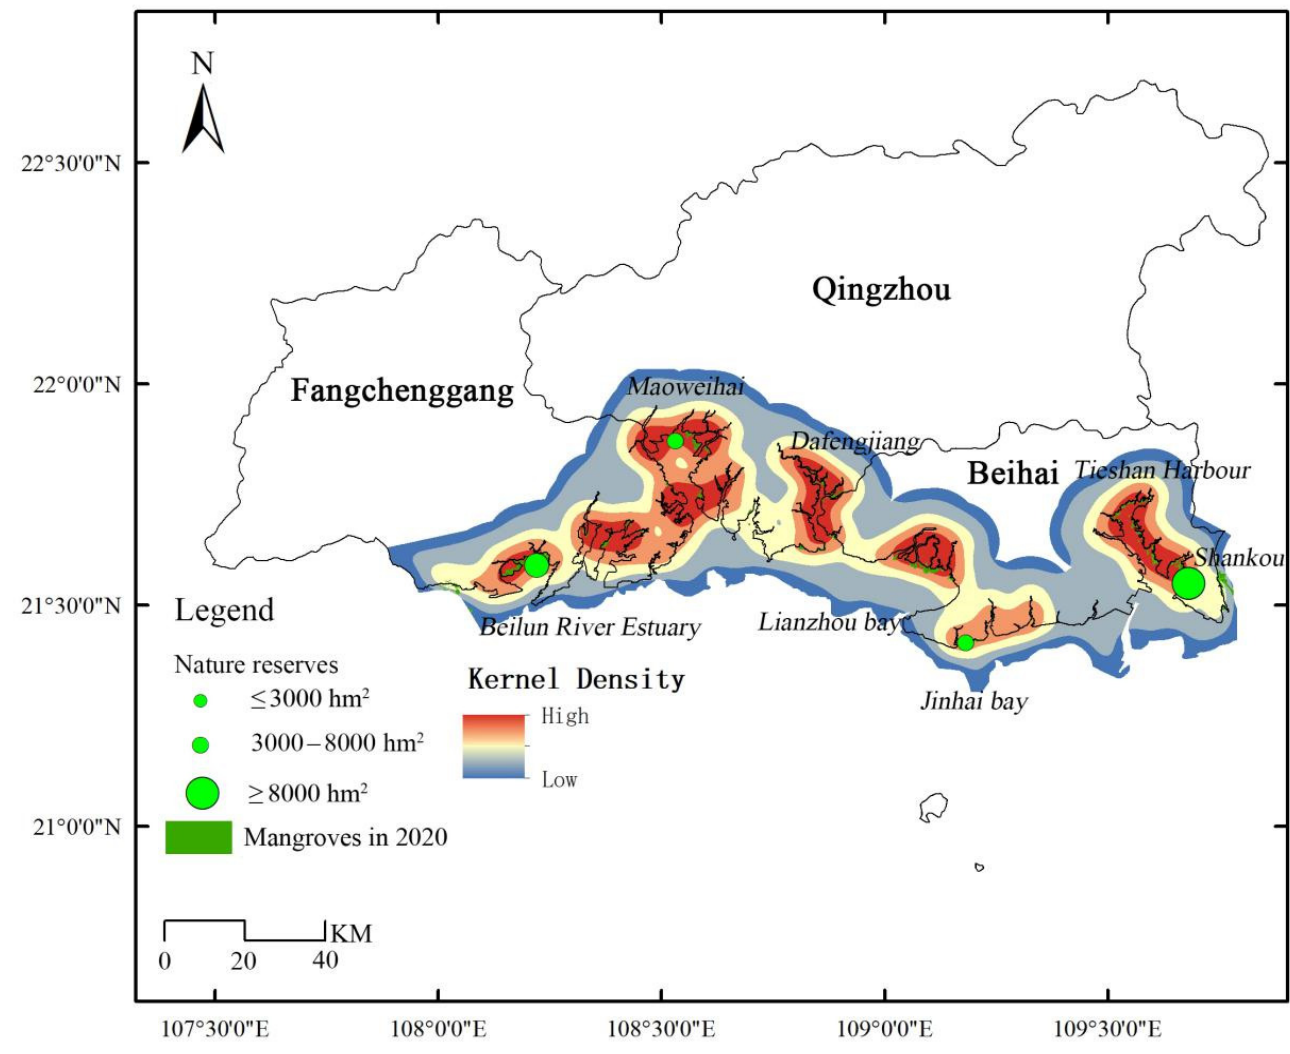
Figure 14. The map of the mangrove distribution and restoration hotspots in the Beibu Gulf.